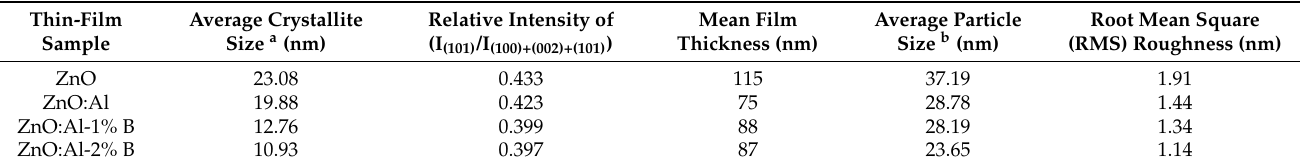
Table 1. Microstructural changes of sol-gel derived ZnO thin films doped with Al and Al-B. Thin-Film Average Crystallite Sample Size a